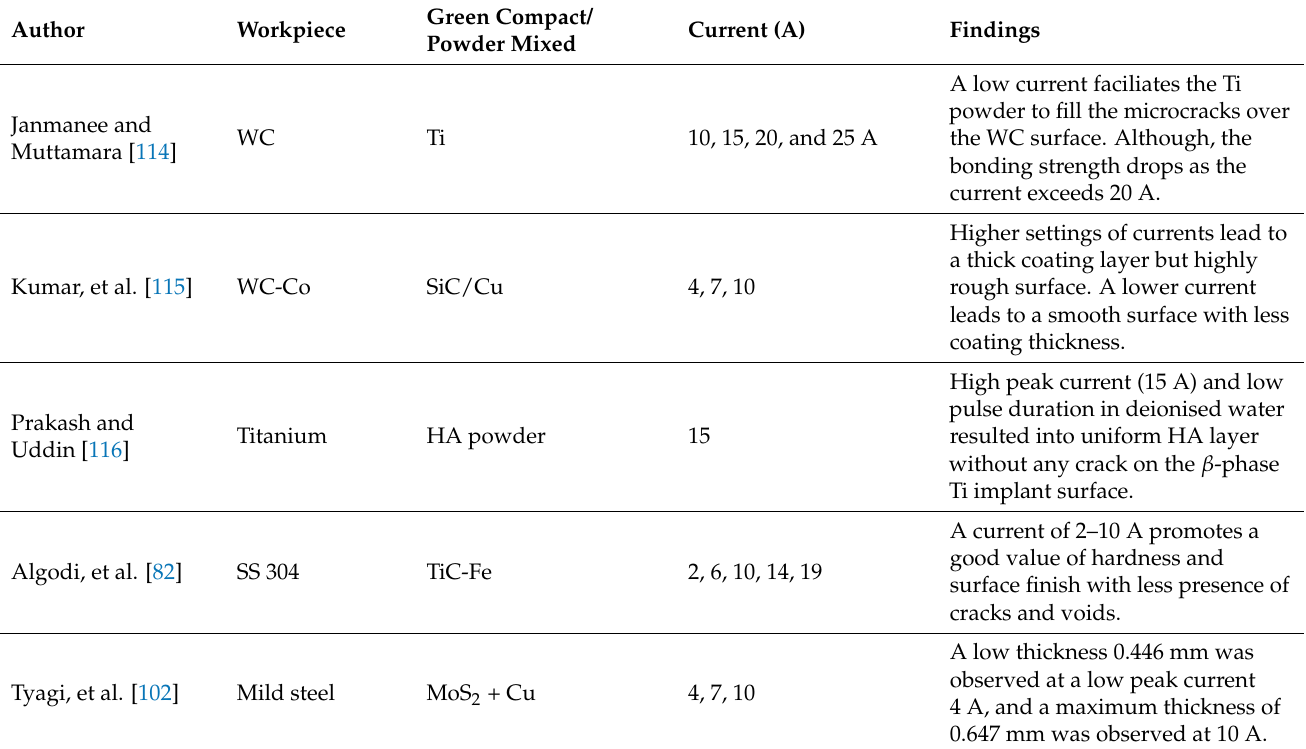
Table 4. The summary of past literature work on the effect of peak